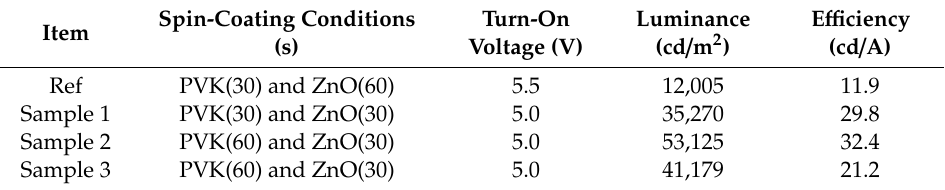
Figure 5. The effects of thickness change of both PVK and ZnO: ( a ) the EL spectra, ( b ) CIE 1931 chart, ( c ) electroluminescence, ( d ) current density as a function of the driving voltage, ( e ) luminance, and ( f ) efficiency. The EL spectra showed a wavelength of 523–529 nm regardless of the sample, and it was found that it was in a similar position on the CIE 1931 diagram. When power is applied to the metal terminal, it can be seen that the green color has a wavelength of 520–530 nm from the electroluminescence. We designed this experiment to find the optimal thickness combination for minimizing the problems caused by the charge imbalance phenomenon. The efficiency was obtained by dividing the luminance by the current density, and was best when the PVK thickness was thin and the ZnO thickness was increased. Table 3. The effects of thickness change of both Poly 9-vinylcarbazole (PVK) and ZnO on current density, luminance, and efficiency. The best results were obtained from Sample 2 although the measured current density was the lowest one. QD without HMDS was used for Sample 3.